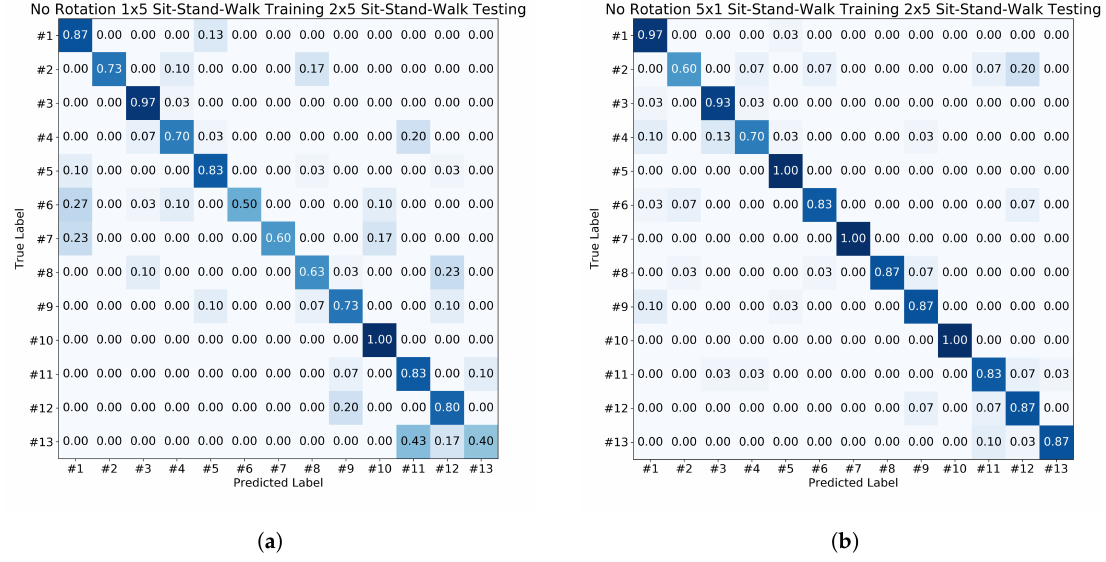
Figure 9. The confusion matrices shown are: ( a ) 3 scenarios × 1 fitting × 5 gestures; ( b ) 3 scenarios × 5 fittings × 1 gesture.